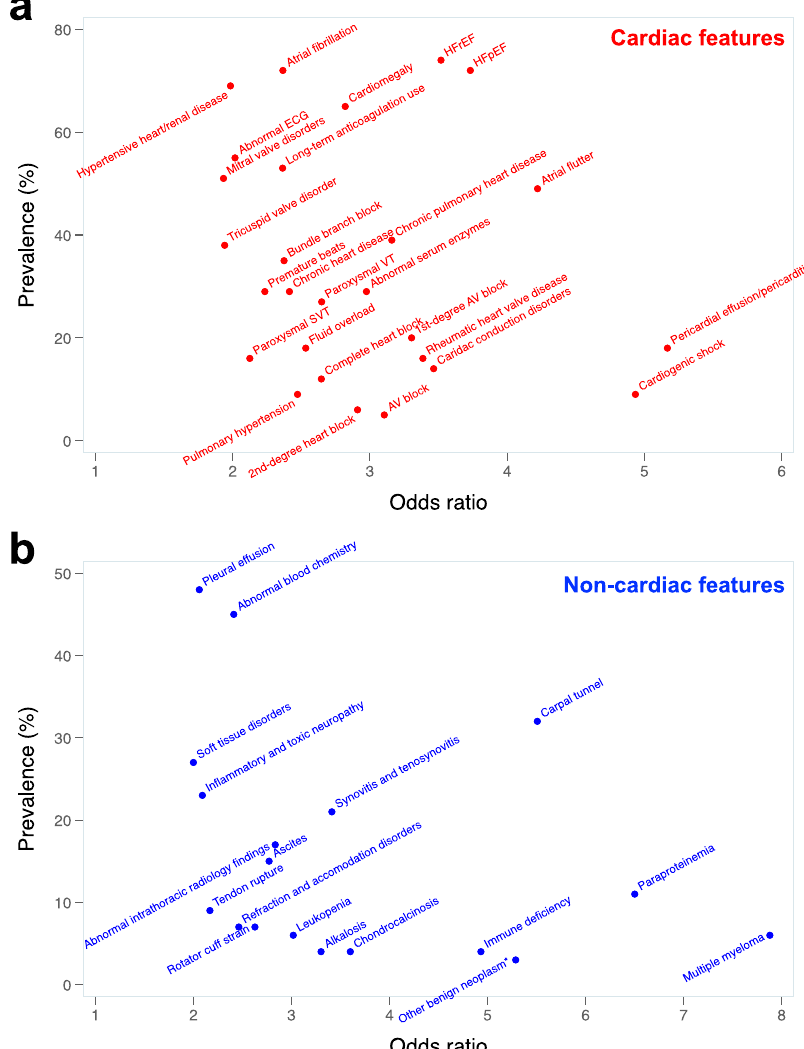
Fig. 2 Odds ratio vs. prevalence for top clinical phenotypes predictive of wild-type ATTR cardiomyopathy. a Cardiac phenotypes associated with wild- type ATTR cardiomyopathy. b Non-cardiac phenotypes associated with wild-type ATTR cardiomyopathy. All features associated with the diagnosis of ATTR cardiomyopathy at a signi fi cance level of P < 10 − 4 , which had an odds ratio (OR) < 10, were included in the graphs. The three features that had an OR > 10 that met the p -value threshold were: hypertrophic cardiomyopathy (OR 15.8, prevalence 11%); localized adiposity (OR 26.6, prevalence 2%); and organ transplantation (OR 23.4, prevalence 4%). Some diagnoses that were associated with ATTR cardiomyopathy (e.g., hypertrophic cardiomyopathy, multiple myeloma) were likely initial misdiagnoses, as these diagnoses (similar to all diagnoses included here) preceded the ATTR cardiomyopathy diagnosis. Univariate logistic regression was used to calculate odds ratios. *Localized to the connective tissue or soft tissue. AV, atrioventricular; ECG, electrocardiogram; HFrE, heart failure with reduced ejection fraction; HFpEF, heart failure with preserved ejection fraction; SVT, supraventricular tachycardia; VT, ventricular